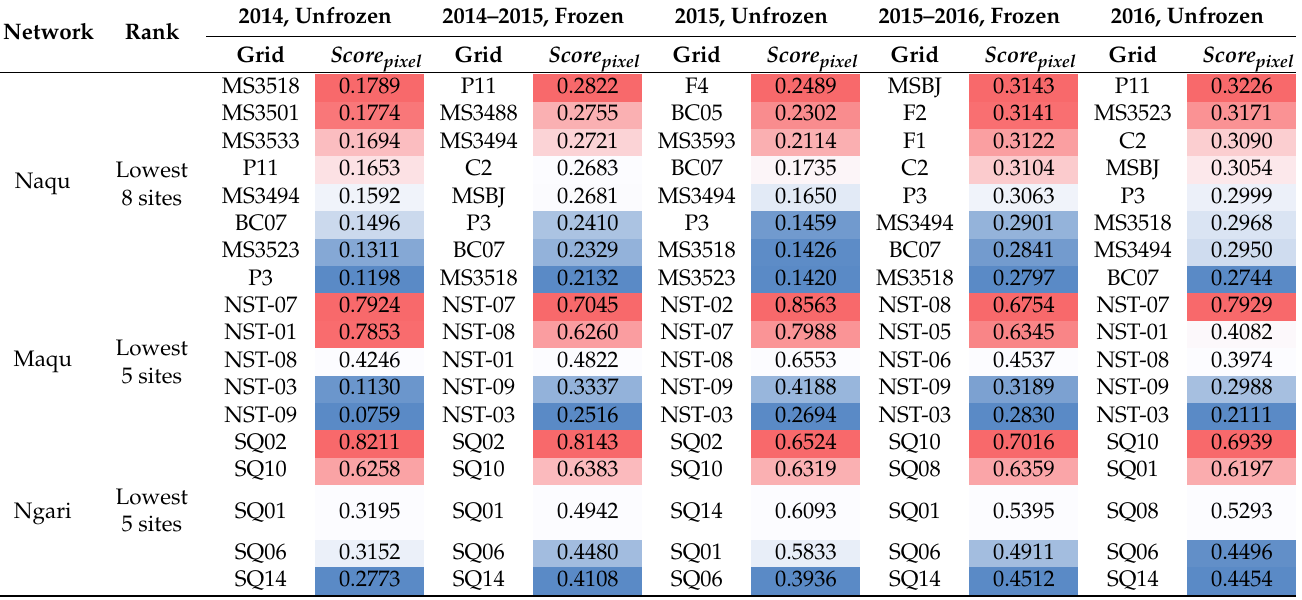
Table 2. Results of the lowest-scoring spatiotemporal heterogeneity of the 0.01 ◦ × 0.01 ◦ grids with in situ measurement sites